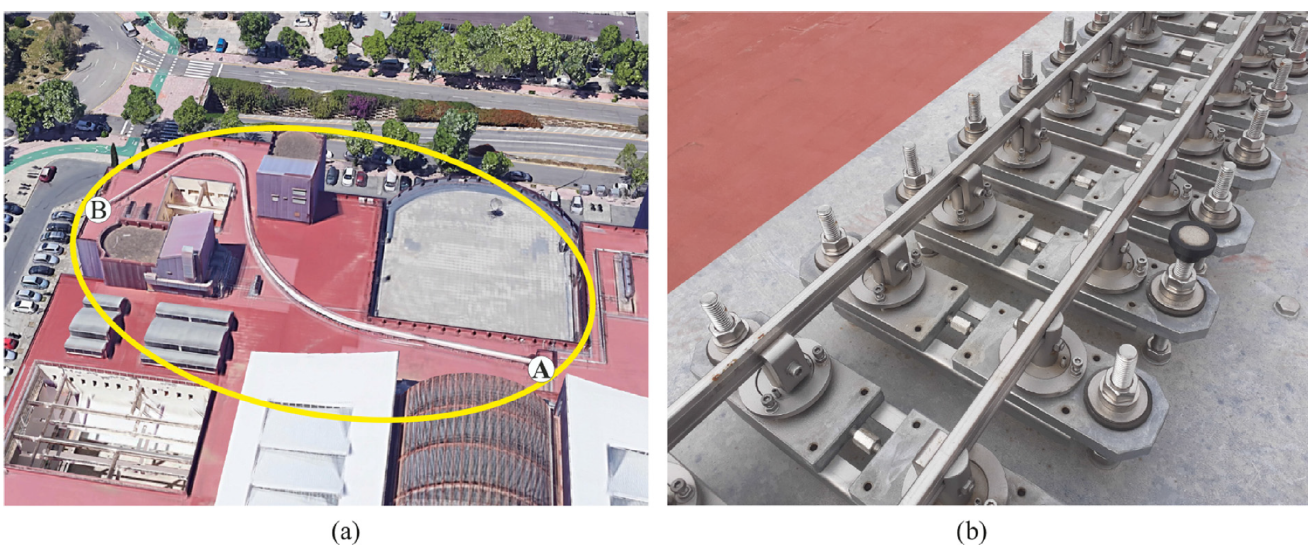
Figure 13. Scaled track at the School of Engineering, University of Seville. ( a ) Aerial view, ( b ) detail of track